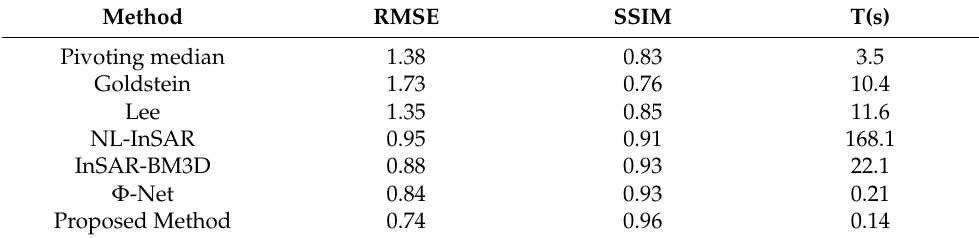
Table 1. Quantitative evaluation for simulated interferogram filtering.